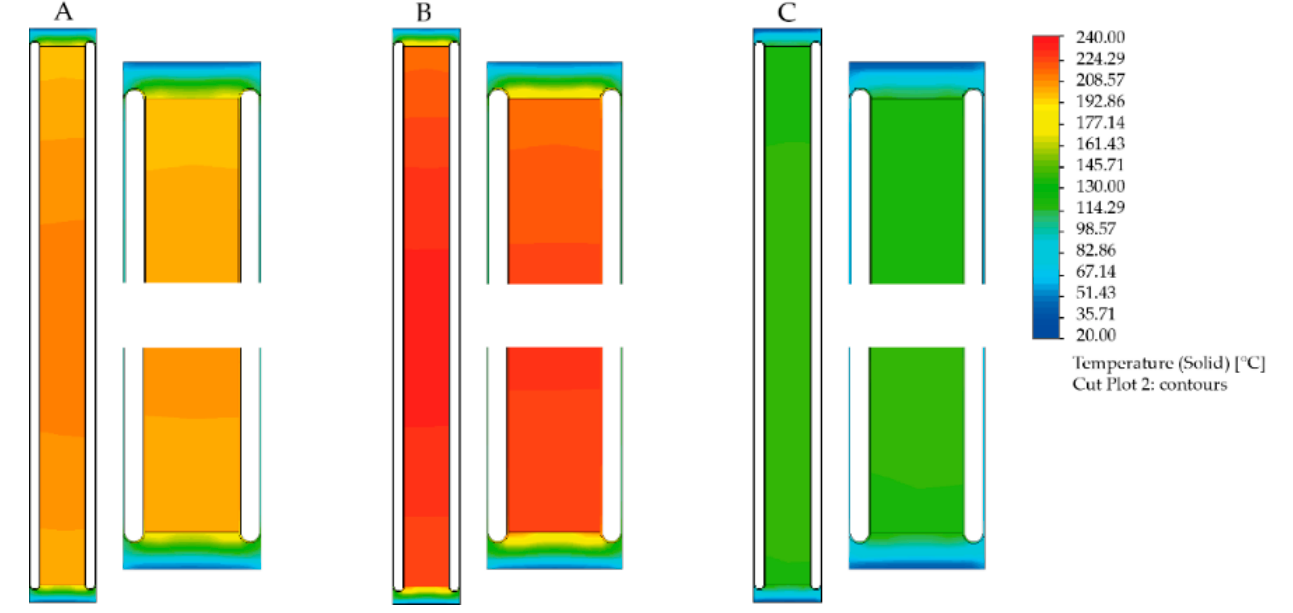
Figure 8. Temperature field in the longitudinal section view of the device and a detailed view of the top and bottom of the model for the North Africa ( A ), South China ( B ) and Indonesia ( C ).